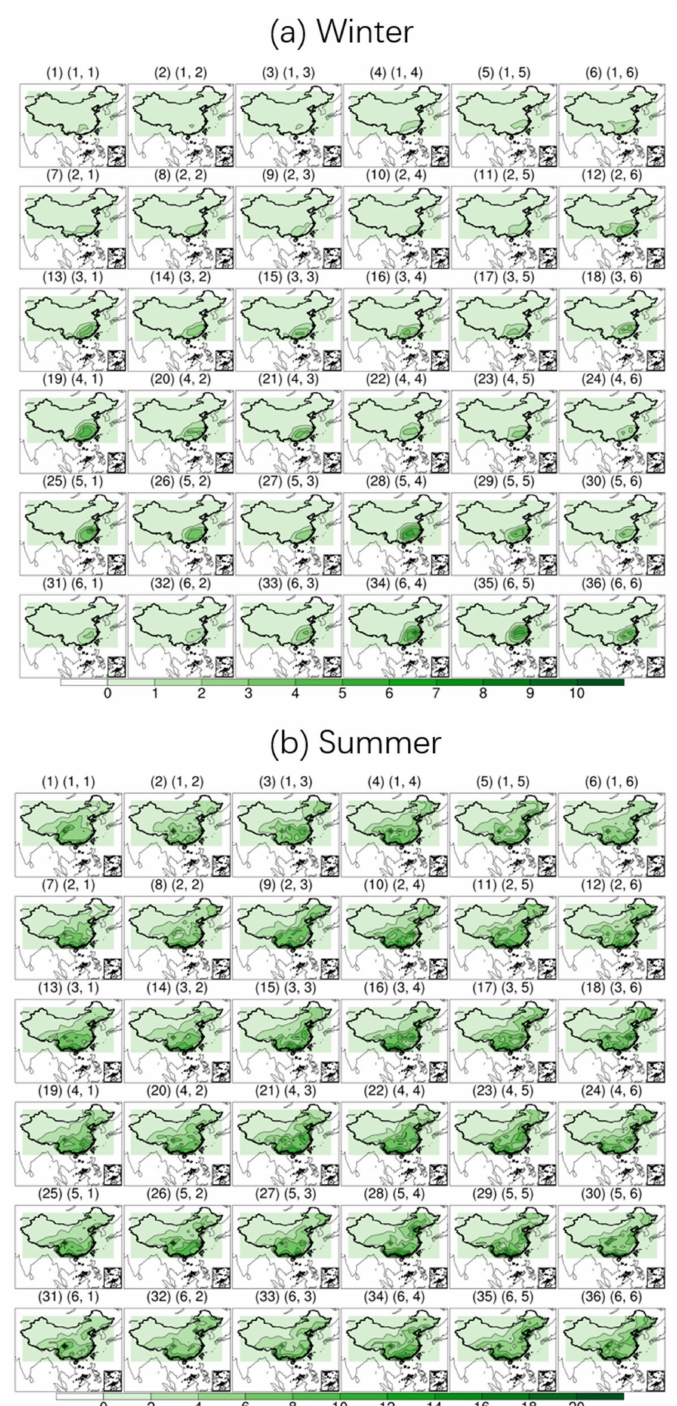
Figure 3. Daily mean-removed average precipitation anomalies (mm/day) corresponding to the 6 × 6 SOMs in Figure 2 over the baseline period 1960–1999: ( a ) in winter (DJF); and ( b ) in summer (JJA). In winter, the average daily precipitation per weather type is 0.21 mm, with category 34 having the most, of about 0.38 mm, and category 10 having the least, of about 0.10 mm. The average daily precipitation for all WPs is plotted in Figure 5a. In summer, the average daily precipitation per weather type is 3.31 mm, with category 21 having the most, of about 3.77 mm, and category 2 having the least, of about 2.61